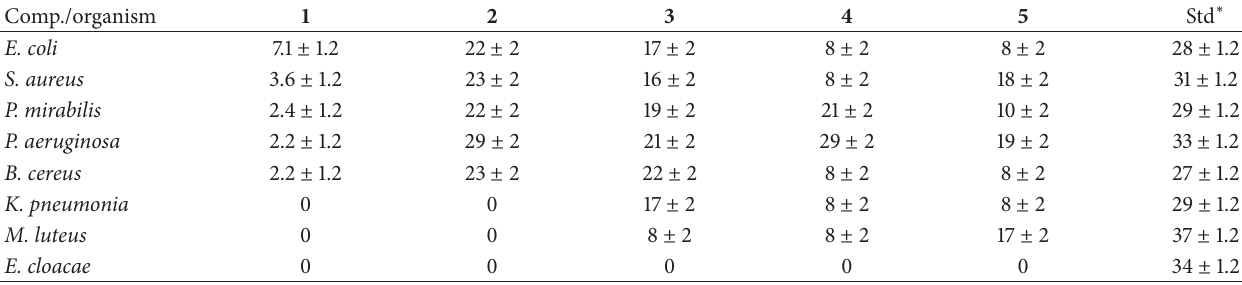
Table 1: Inhibition zones (mm) of 1–5 isolated from C. sativum against bacteria.